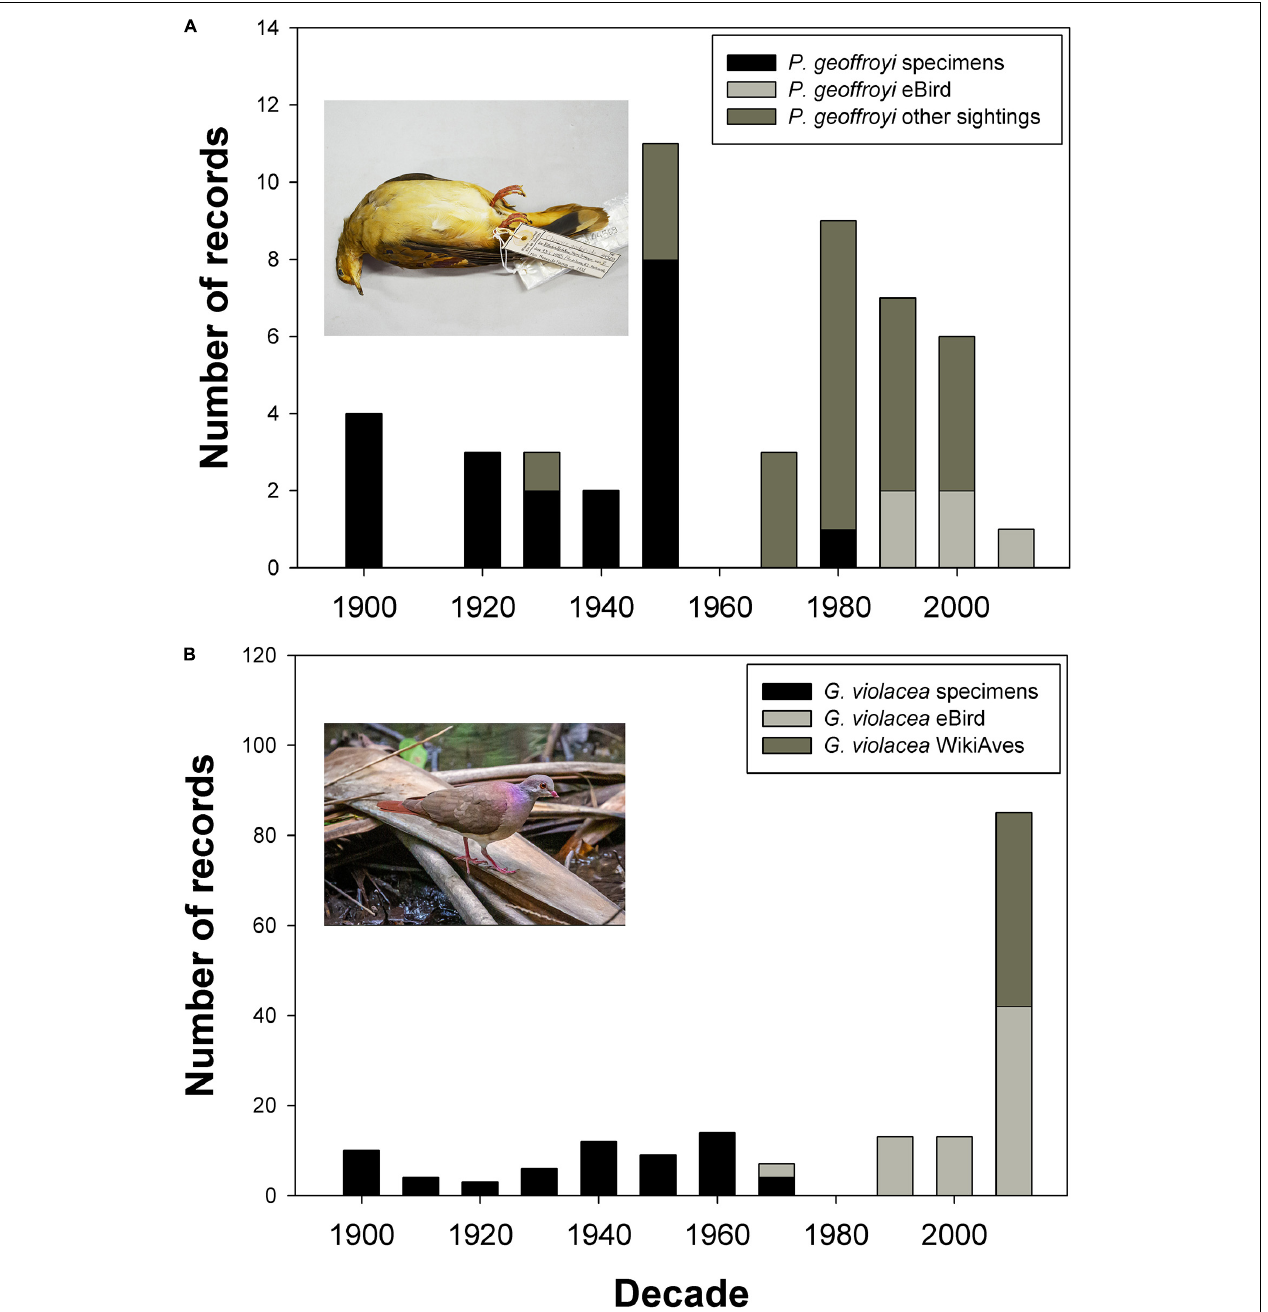
FIGURE 2 | Temporal changes in evidence base for records of (A) Purple-winged Ground Dove Paraclaravis geoffroyi and (B) Violaceous Quail-Dove Geotrygon violacea ; specimens of both species were historically collected with similar historical frequency, but only the continued presence of Violaceous Quail-Dove has been unambiguously documented in the last 35 years. Image inset in (A) is MNRJ#44569, a female Purple-winged Ground Dove collected on Estrada do Pau da Fome, Taquara in Rio de Janeiro, Brazil on 15/01/1985 (image Guilherme Brito); image inset in (B) is #WA3594946, an adult male Violaceous Quail-Dove photographed at Gália, São Paulo, Brazil on 02/12/2019 (image Paulo Fernando